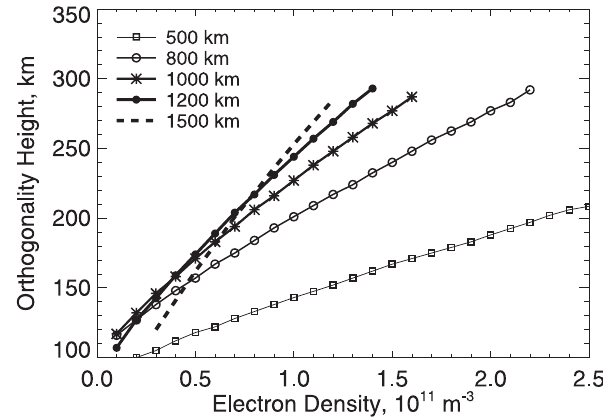
Fig. 6. Heights of the orthogonality condition (with refraction taken into account) for the Hankasalmi radar at ranges 500, 800, 1000, 1200 and 1500km. A uniform electron density distribution, both horizontally and vertically, is